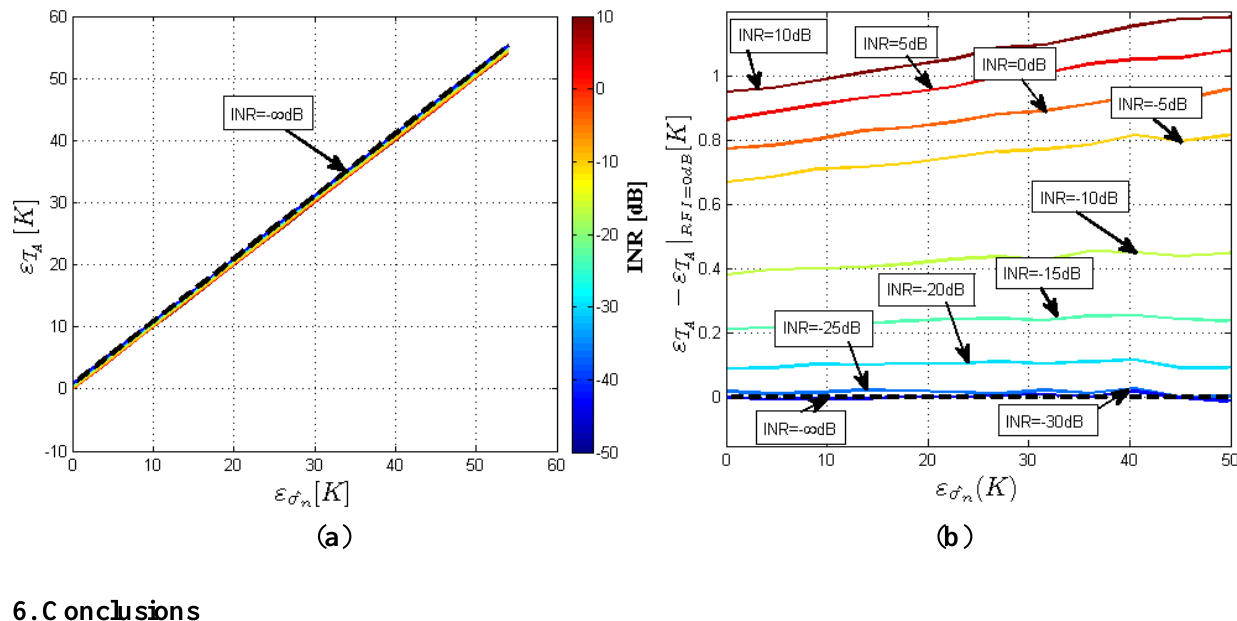
Figure 17. Error in the estimation of the retrieved temperature using the LLMMSE denoising algorithmin as a function of the error in the a-priori estimation of the thermal noise power. Both errors are represented in Kelvin. Colored lines represent RFI contaminated radiometric signals with an INR determined by its label. Black dotted line represents a radiometric signal in abscense of